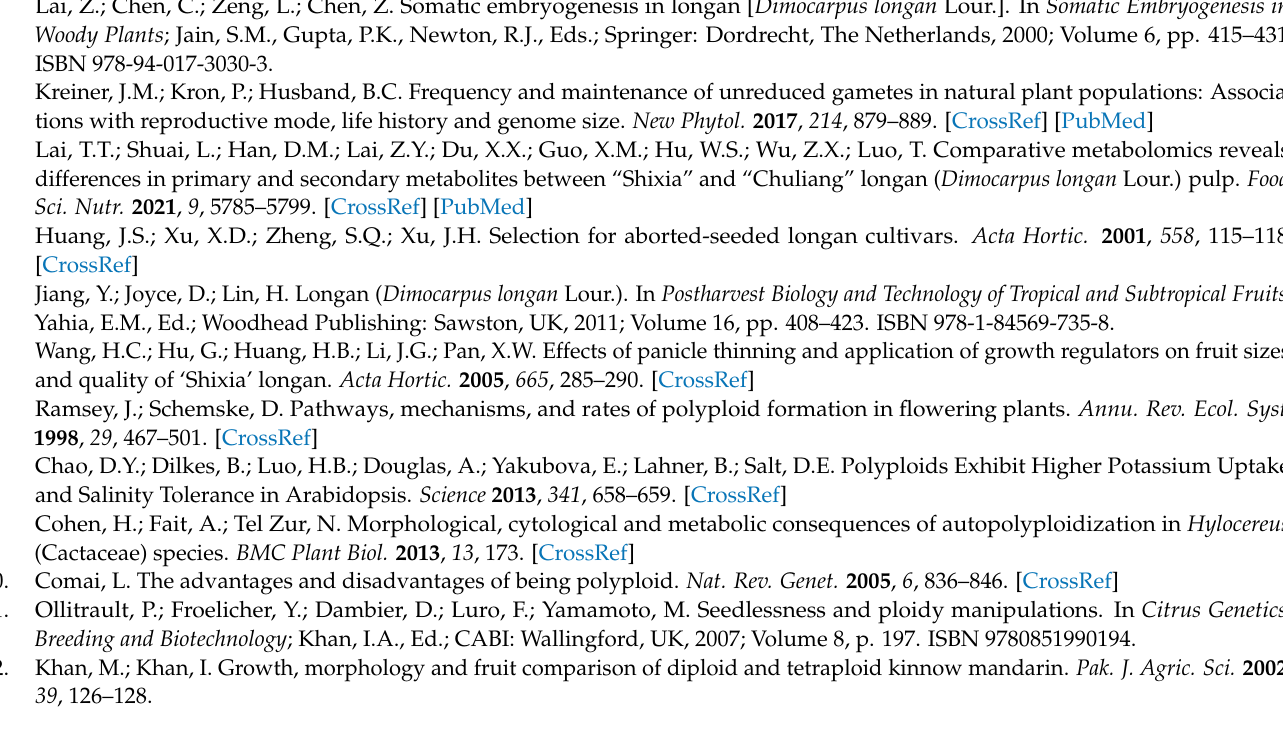
diploid plants; Figure S2: The leaf morphology of triploid and diploid plants; Figure S3: Observation of stomatal characteristics and distribution of triploid and diploid leaves; Figure S4: Observation of chloroplast number in stomatal guard cells of triploid and diploid leaves; Table S1: The morphological characteristics of male flower buds according to the meiotic process of microspore mother cells; Table S2: The leaf characteristics of triploid and diploid plants; Table S3: Determination of chloroplast number in stomatal guard cells of triploid and diploid